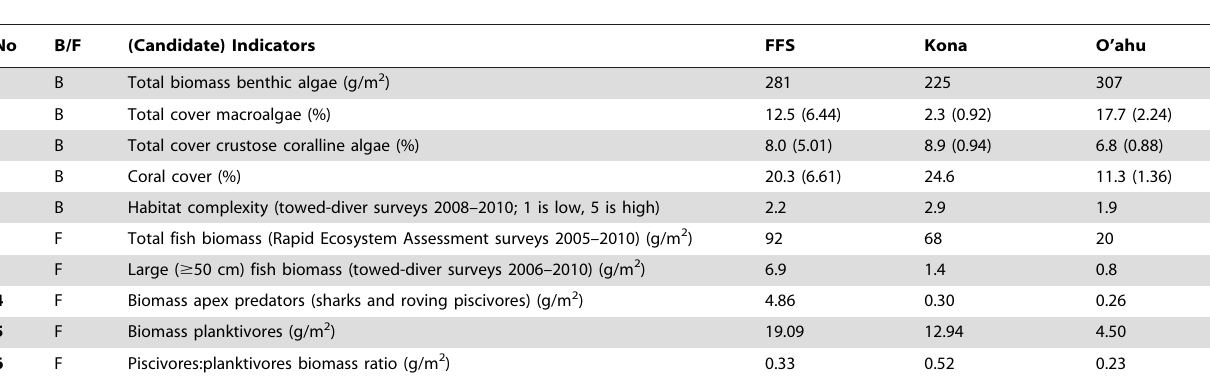
Table 3. Benthic (B) and fish (F) related indicators for coral reef health from survey data (unnumbered; NOAA Fisheries Coral Reef Ecosystem Division and Hawai’i Department of Aquatic Resources indicators) and candidate indicators (numbered) for fishery